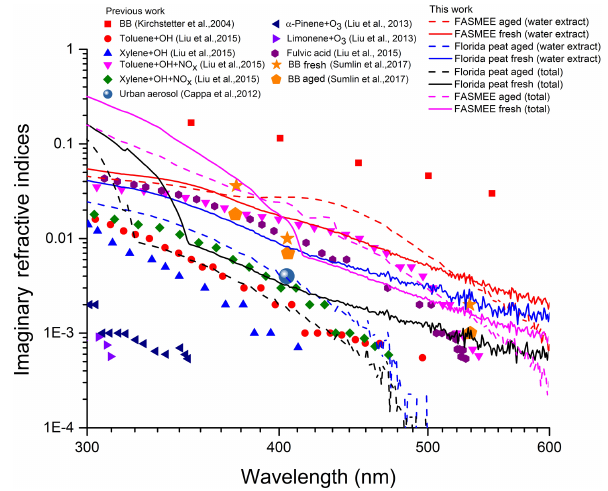
Figure 11. Comparison of the imaginary part of the bulk refrac- tive indices from previous work with water extracts and total (hex- ane + water) extracts of the fresh BBOA (solid lines) and aged BBOA (dotted lines) as a function of